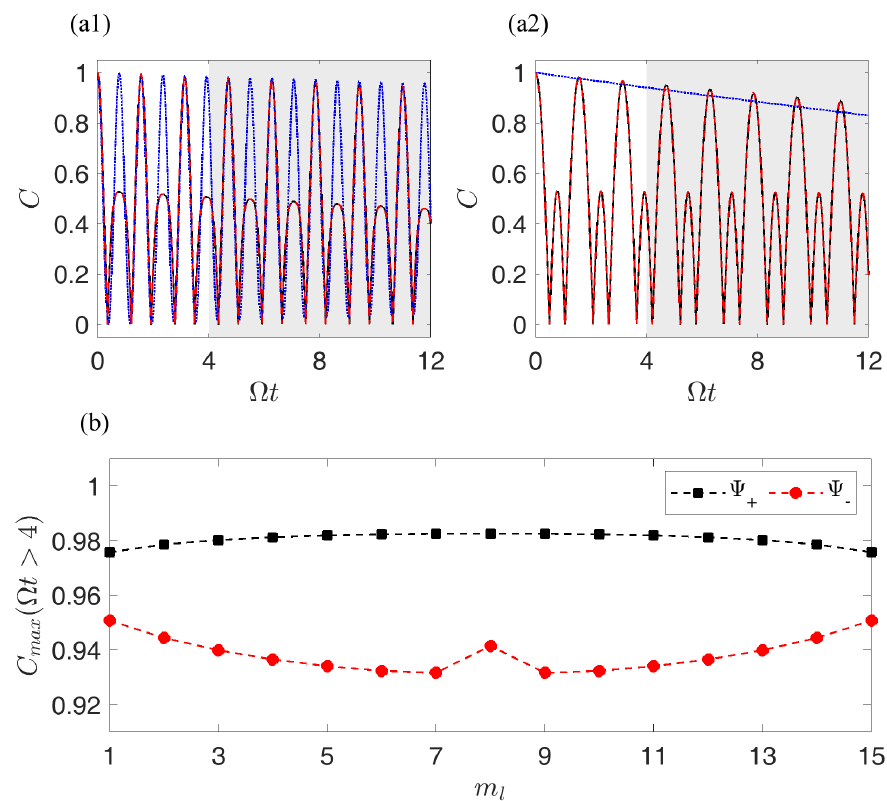
Figure 6. Calculated dynamics for the initial states of | ψ + (cid:105) ( a1 ) and | ψ − (cid:105) ( a2 ), respectively. Time evolutions of concurrence C . The solid black, the dotted blue, and the dashed red curves correspond to the parameters: ( m l , m r ) = ( 1,15 ) , ( m l , m r ) = ( 8,8 ) , and ( m l , m r ) = ( 15,1 ) . ( b ) Maximal concurrence C max as a function of the number of atoms m l with total atom number n =16 for the evolution time 12 > Ω t > 4 (as indicated with shading region in Figure 6a1,a2). The initial states are | ψ + (cid:105) (black squares) and | ψ − (cid:105) (red circles), respectively. Other parameters are given at the beginning of Section